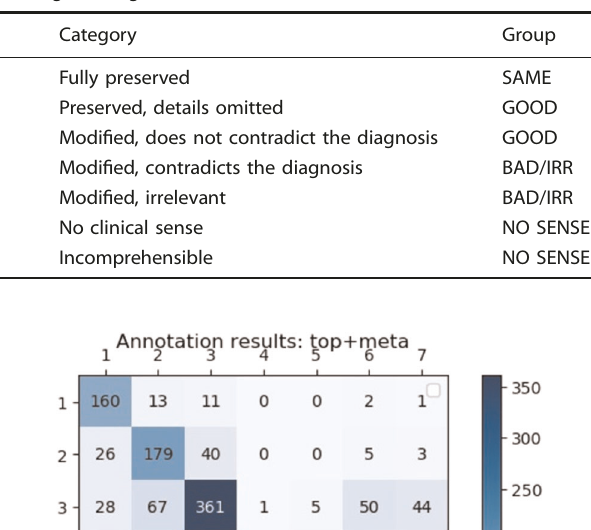
Table 4. Annotation categories for the human evaluation of the meaning of the generated text.